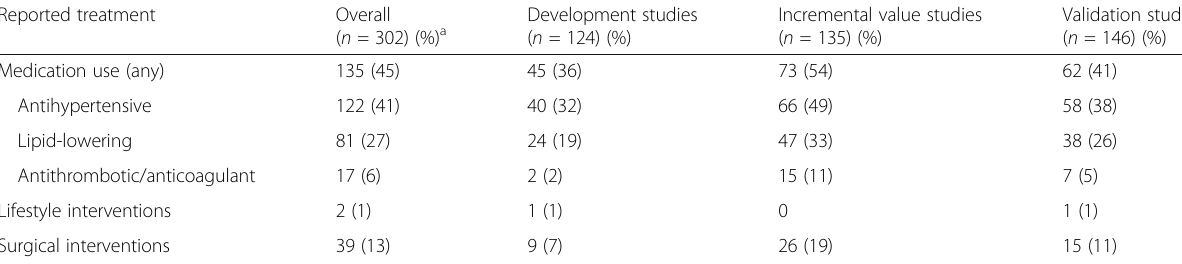
Table 2 Reporting of treatment use by study type Reported